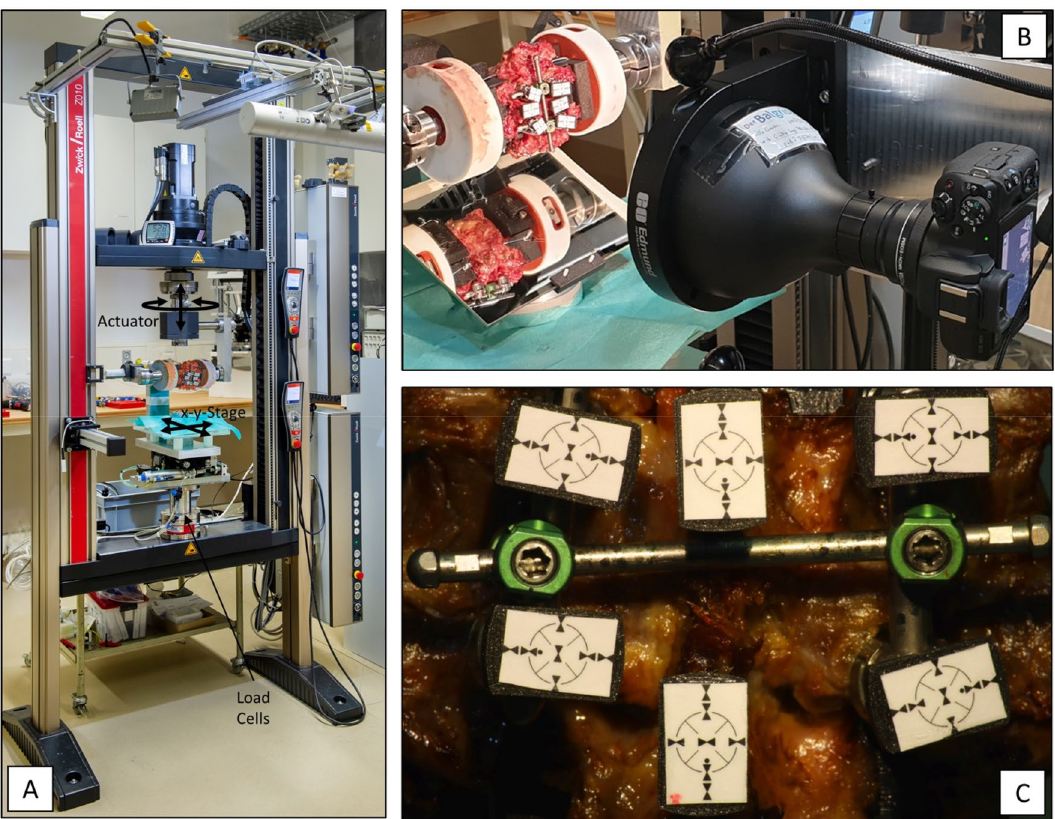
Figure 3. ( A ) Image of the biomechanical test setup with the mounting position to perform flexion–extension loading. ( B ) Telecentric camera system. ( C ) Telecentric image of an illustrative specimen with the six crosshair- labels to measure translational and rotational displacement of the two vertebral bodies and the four screw heads.